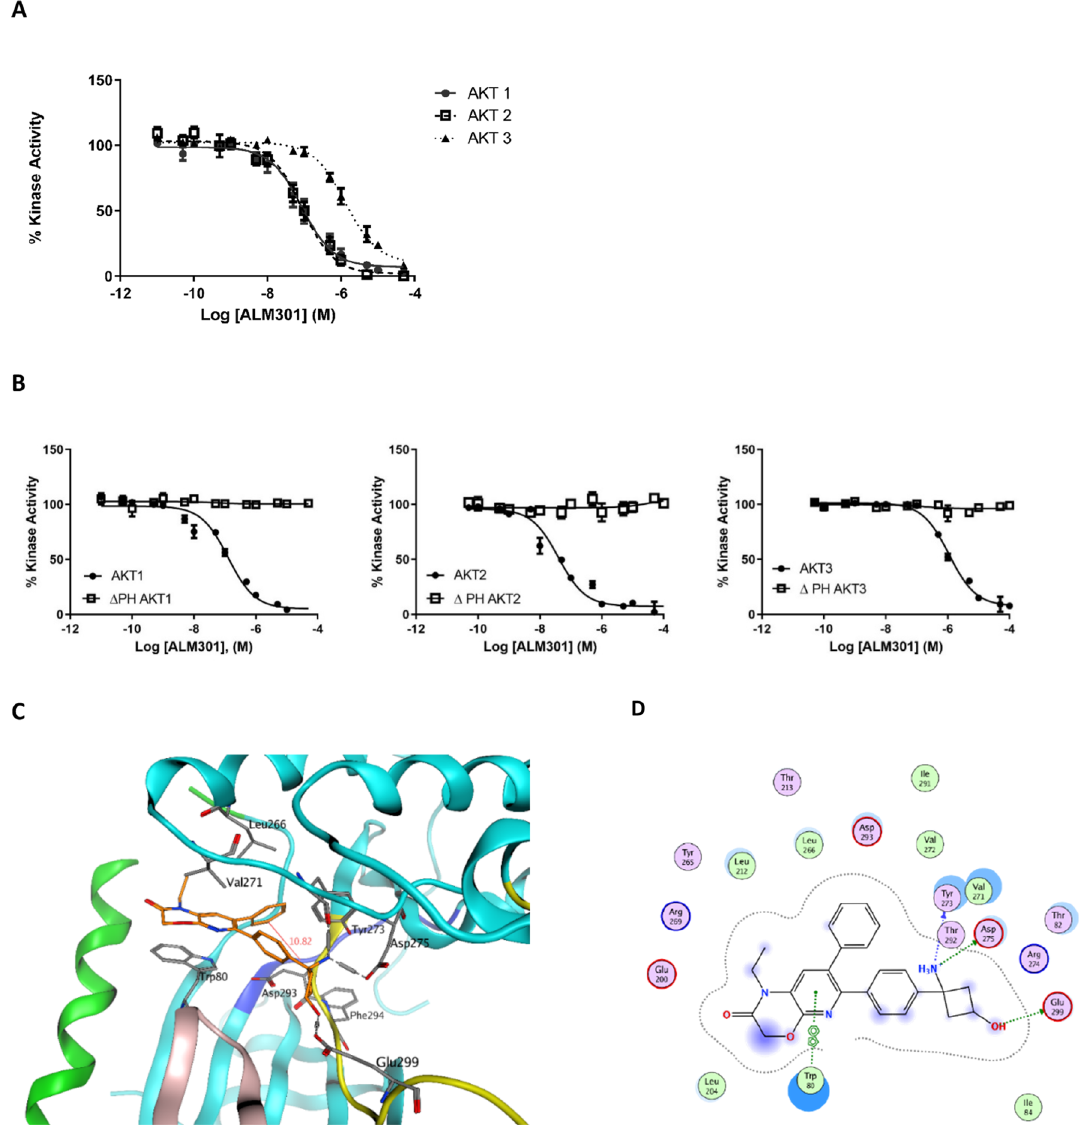
Figure 2. Biochemical inhibition of AKT isoforms versus pH domain null isoforms and ALM301 docking studies. ( A ) Biochemical inhibition of AKT1/AKT2/AKT3 and ( B ) related PH domain null isoforms using ALM301. ( C ) Docked pose of ALM301 in the allosteric pocket of AKT2 based on the crystal structure data generated using the closely related analogue compound 3. ( D ) Interaction diagram based on the docking of ALM301 with the allosteric pocket of AKT2 depicting key amino acid